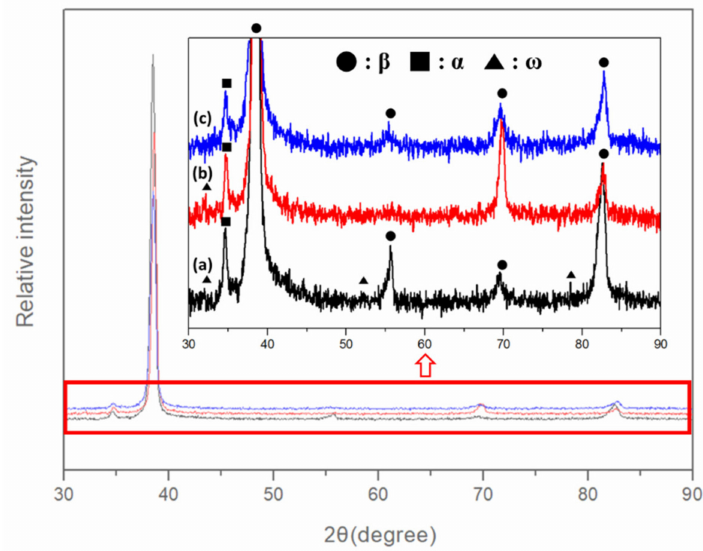
Figure 2. X-ray diffraction patterns obtained from STA-treated TNZ40 alloys: ( a ) TNZ40, ( b ) TNZ40 + 0.1 Si, and ( c ) TNZ40 + 0.2 Si.